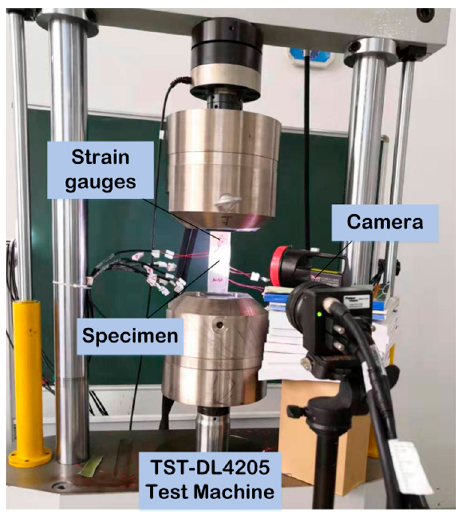
Figure 3. The schematic representation of the specimen and the set-up for tensile strength testing.